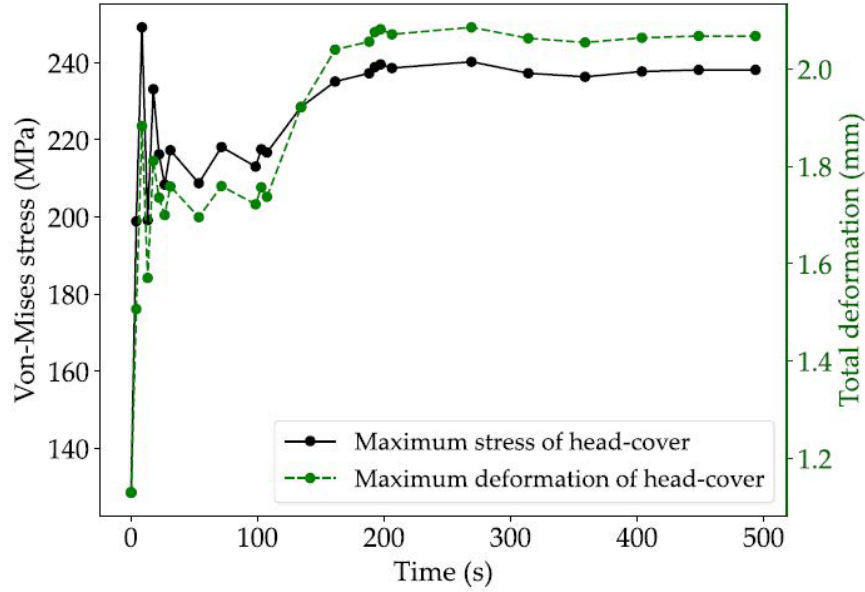
Figure 16. The maximum stress and the maximum deformation of the head-cover during turbine start-up.